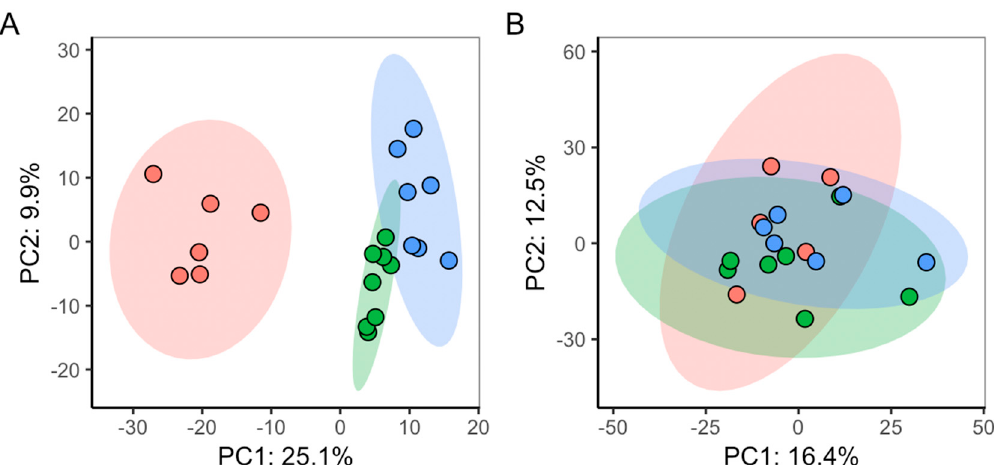
Figure 3. PCA scores plots comparing the DIMS metabolic phenotypes of ( A ) synchronised algal cell cultures grown in alternating light:dark conditions, and of ( B ) non-synchronised algal cell cultures grown in constant light. Plotted are PCA scores for samples taken at 4 h 15 min ± 15 min (Red), 8 h 15 min ± 15 min (Green)) and 12 h 15 min ± 15 min (Blue).